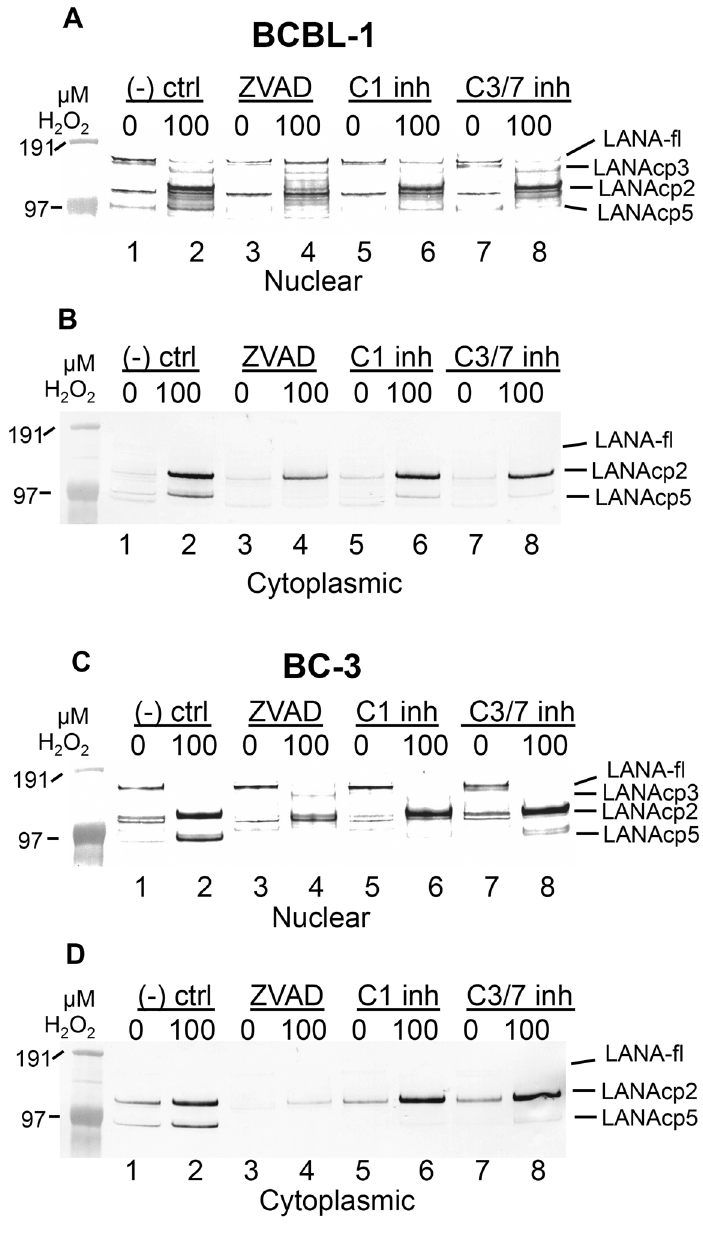
Fig 4. Caspase inhibitors block oxidative stress-induced changes in LANA. BCBL-1 (A, B) or BC-3 (C, D) cells were treated with PBS vehicle control or 100 μ M H 2 O 2 in the presence of 50 μ M Z-FA-FMK (- ctrl), a negative control peptide (lanes 1 and 2), ZVAD-FMK (ZVAD), a pan-caspase inhibitor (lanes 3 and 4), a specific inhibitor of caspase-1 (C1 inh) (lanes 5 and 6) or a specific inhibitor of caspase-3/7 (C3/7 inh) (lanes 7 and 8). Nuclear (A, C) and cytoplasmic (B, D) extracts were harvested and LANA expression was analyzed by western blot and probed with antibody to FLAG, anti-rabbit secondary antibody conjugated to alkaline phosphatase and visualized using stabilized Western Blue substrate (Promega). Results are representative of 3 separate experiments for controls and ZVAD and 2 separate experiments for the C1 and C3/7 inhibitors. Molecular weight markers are shown to the left. To the right of the blots the different forms of LANA are indicated and include the location for full length LANA (LANA-fl) and three forms of LANA migrating below full length LANA with presumptive designations as LANAcp3, LANAcp2 and LANAcp5 based on their mobility.